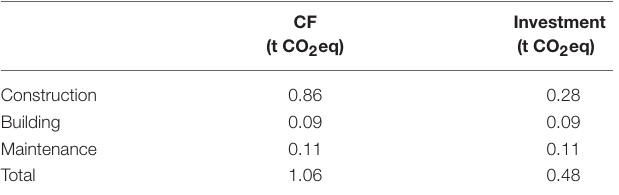
as the ratio between CO 2 eq emitted (CF) and the produced electricity (Moro and Lonza, 2018). This ratio can be included in the list of performance indicators: the lower its value, the better the performance (Ang and Su, 2016).